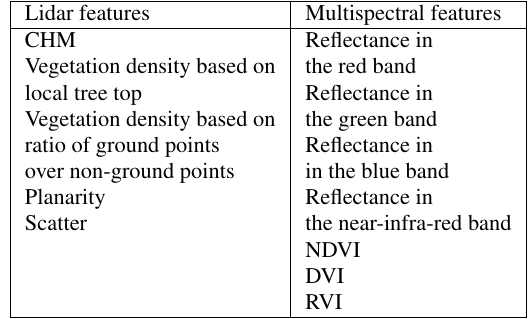
Table 3. Computed features both at pixel and object levels.